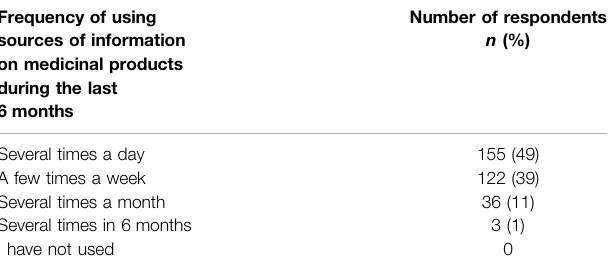
TABLE 2 | The declared frequency of using sources of information on medicinal products in the last 6 months ( N (cid:1) 316). Frequency of using sources of information